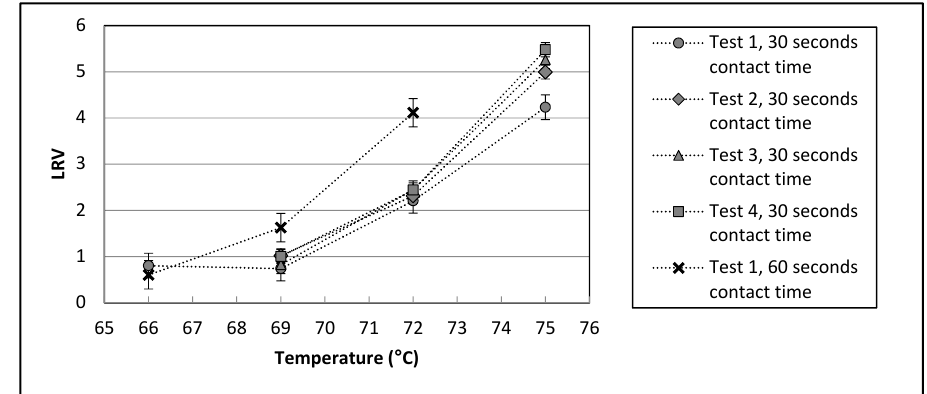
Table 5. Effect of turbidity on log removal values ( LRV ) at 60 ˚ C for three replicate experiments, native E.